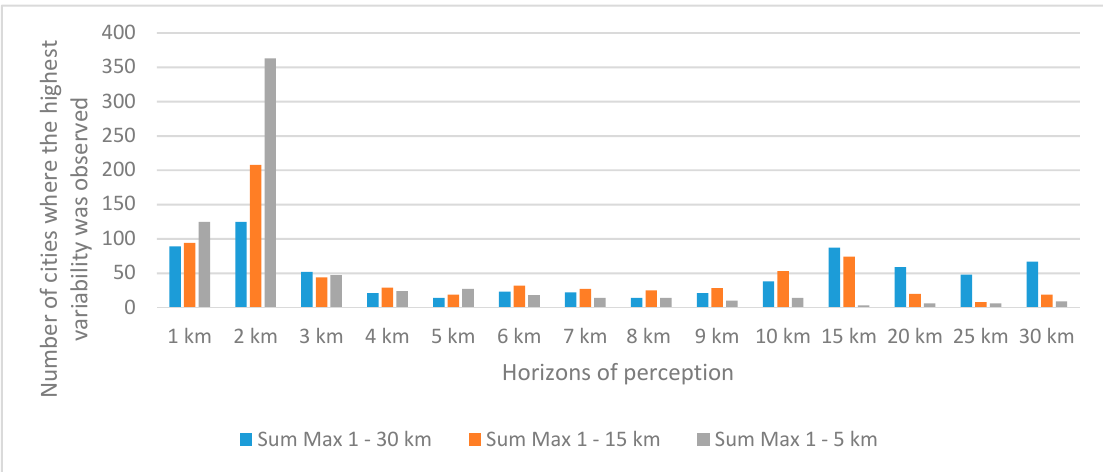
Figure 7. Sum of absolute difference of normalized average WUP values across concentric city rings for 1 to 5 km (grey), 1 to 15 km (orange), and 1 to 30 km (blue).